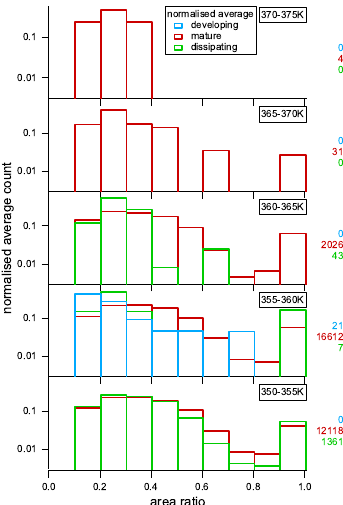
Figure 8. Vertical profile of area ratio histograms. The histograms are normalised to a total value of 1 (each bin divided by the total number of counts) to make their shapes comparable. The coloured numbers at the right hand side indicate the number of particle im- ages considered in this